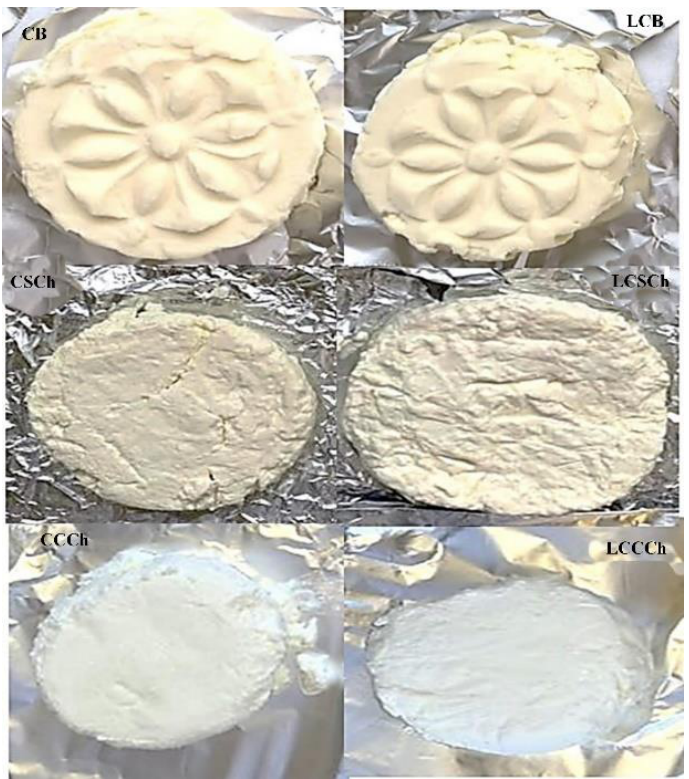
Figure 1. Pictures of produced dairy products. CB – control butter, LCB – low cholesterol butter, CSCh – control soft cheese, LCSCh – low cholesterol soft cheese, CCCh – control cottage cheese, LCCCh – low cholesterol cottage cheese.